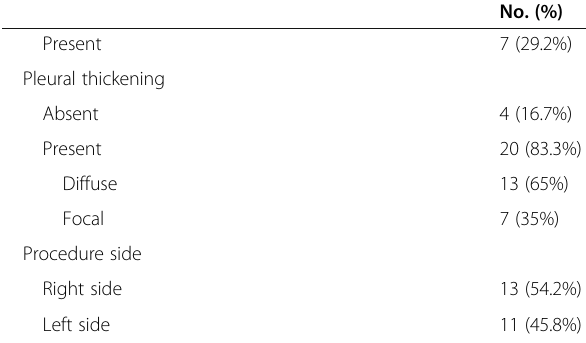
Table 1 Demographic data, clinic-radiologic, and thoracoscopic findings of the studied patients ( n = 24)